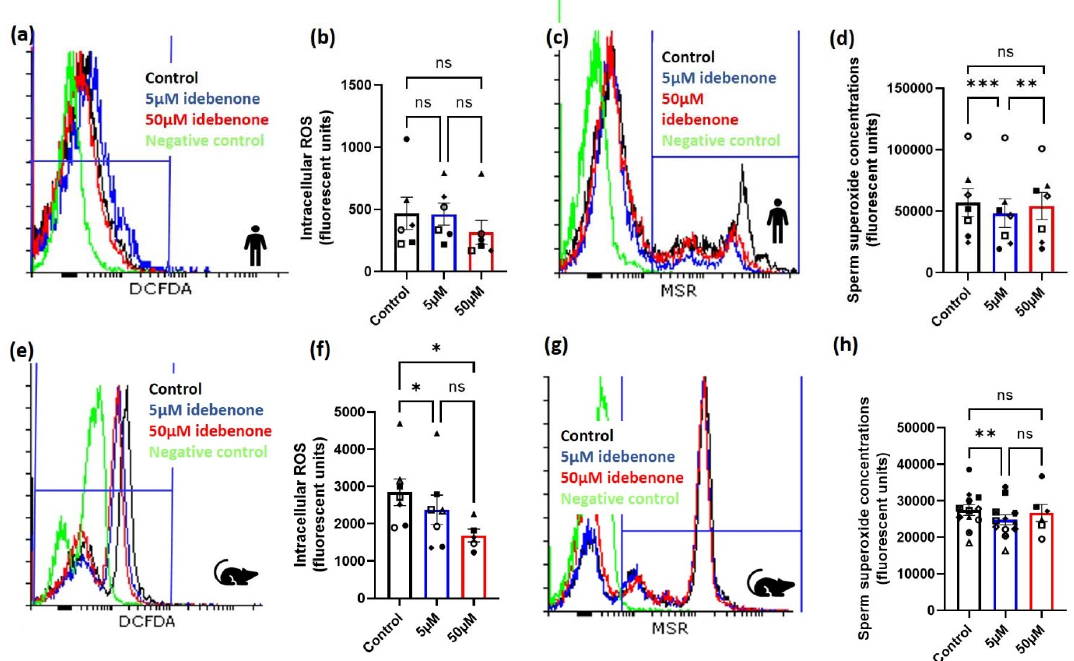
Figure 1. Idebenone in vitro reduces sperm reactive oxygen species concentrations in advanced paternal age. ( a ) Representative FACS histograms for human sperm for intracellular ROS, ( b ) Human sperm intracellular ROS concentrations following 1 h incubation in differing concentrations of idebenone, ( c ) Representative FACS histograms for human sperm for superoxide, ( d ) Human sperm superoxide concentrations following 1 h incubation in differing concentrations of idebenone, ( e ) Representative FACS histograms for mouse sperm for intracellular ROS, ( f ) Mouse sperm intracellular ROS concentrations following 1 h incubation in differing concentrations of idebenone, ( g ) Representative FACS histograms for mouse sperm for superoxide, ( h ) Mouse sperm superoxide concentrations following 1 h incubation in differing concentrations of idebenone. N = 6 human sperm biological replications for intracellular ROS and N = 7 human sperm biological replicates for superoxide concentrations. N = 6 mouse sperm biological replicates for intracellular ROS and N = 11 mouse sperm biological replicates for superoxide concentrations. Data were analyzed by a repeated measure ANOVA with a Tukey’s multiple comparison test. Different symbol shapes represent the same biological sample; 5 μ M—5 μ M idebenone, 50 µ M—50 µ M idebenone, ns—not significant. * p < 0.05, ** p < 0.01, *** p <